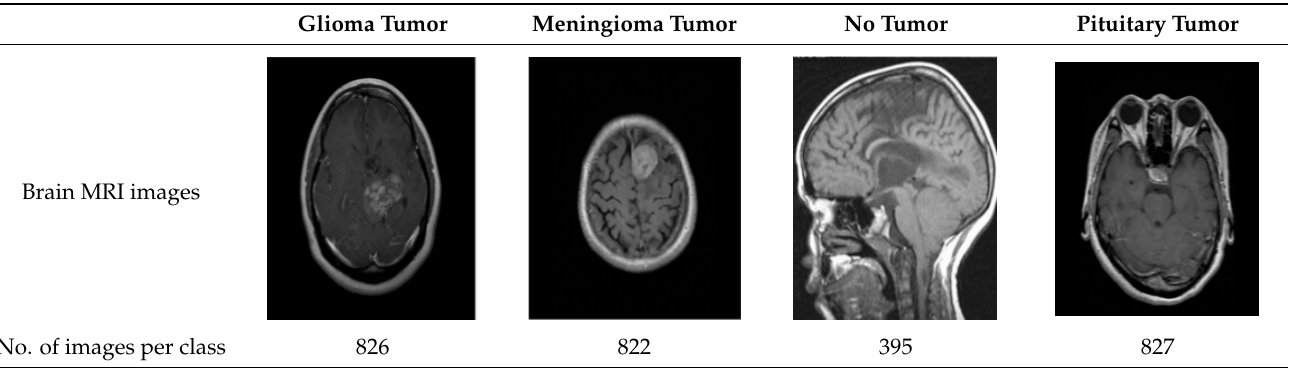
Table 1. Details of online brain MRI dataset.